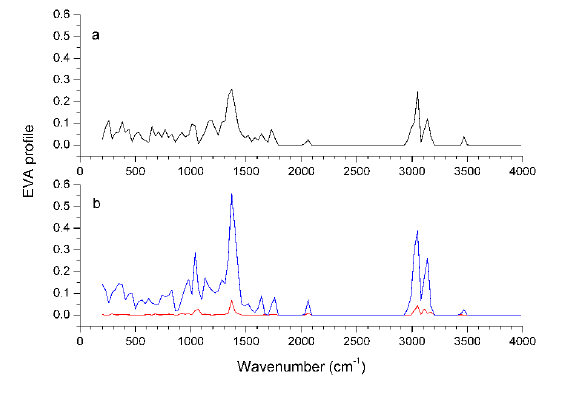
Figure 7. Characteristics of the EVA profiles. EVA pseudo-spectra of the weakest compound 19 (a) and the most potent compound 55 (b) are given by black and blue lines, respectively; the Discriminant Power profile of the training set is given by the red